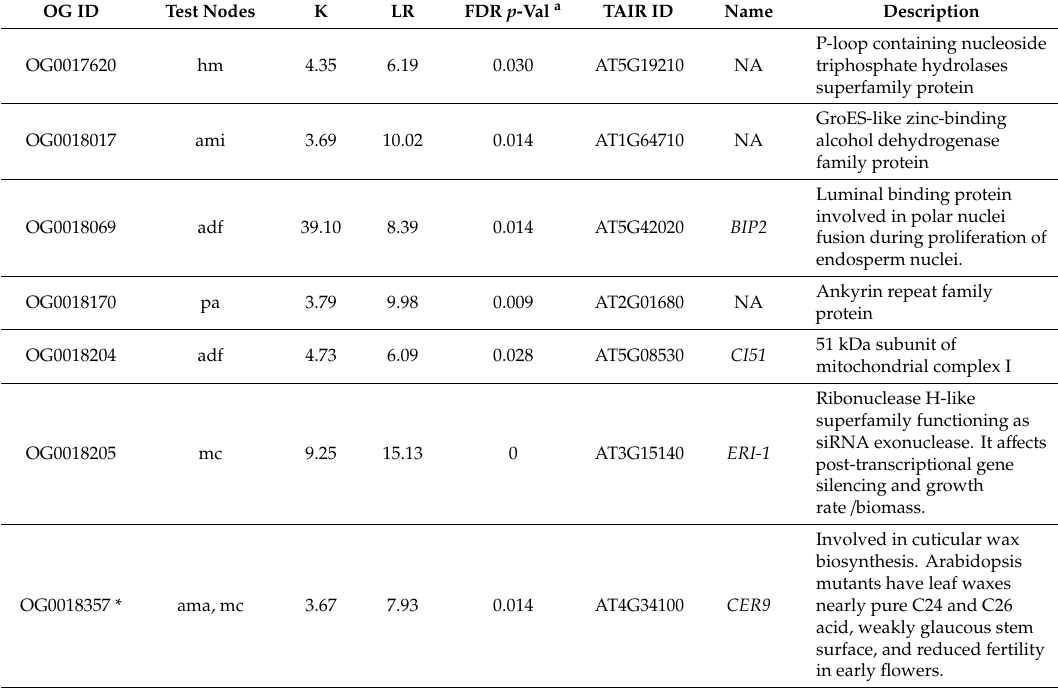
Table 3. Homology-based functional annotation of the 7 genes undergoing branch-specific selection intensification after multiple test corrections (FDR: 0.05) according to ABSREL and RELAX. The higher the K value, the higher the predicted entity of selection intensification. Node name abbreviations: adf, A. donaciformis ; ama, A. donax var. macrophylla ; ami, A. micrantha ; hm, H. macra ; mc, M. caerulea ; pa, P. australis